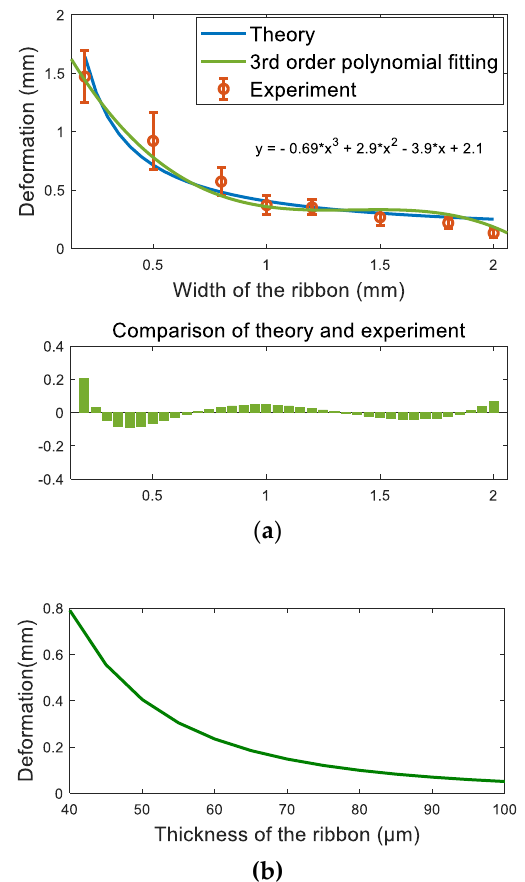
Figure 8. Influence of the width and thickness on the deformation of the ribbon. ( a ) deformation as the function of the width and comparison of the theoretical estimation and experiments; ( b ) deformation as the function of the thickness.